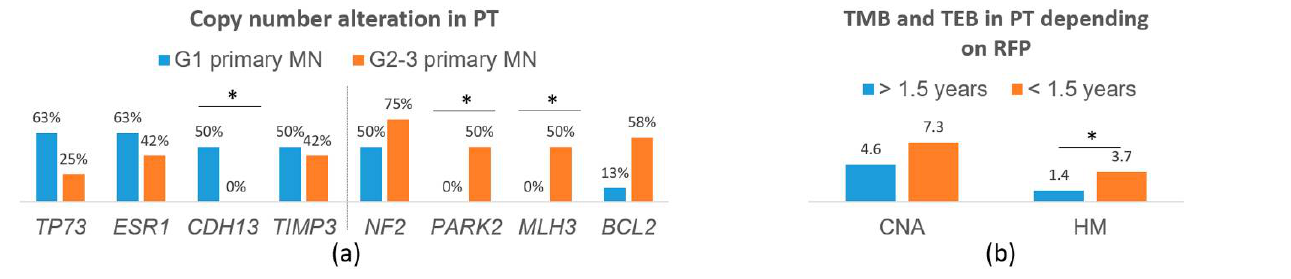
Figure 1. Genetic and epigenetic main characteristics. ( a ) Outstanding somatic copy number altera- tions on primary meningiomas depending on the tumor grade. ( b ) Copy number alterations and tumor epimutation burden (average number of epigenetic changes) according to recurrence-free survival period, divided into less than 1.5 years to the first recurrence or more than 1.5 years to the first recurrence. ( c ) Kaplan–Meier analysis of recurrence-free survival shows three independent prognostic factors: CDKN2B and PTEN epigenetic alterations (HM), and HIC1 copy number altera- tion (CNA). In each graph, the wild-type situation is in red and HM or CNA is in blue. ( d ) Cox Hazard ratio data to corroborate the strength of Kaplan–Meier analysis. ( e ) Evolution of the genetic and epigenetic burden from primary meningiomas to the first recurrence. ( f ) Pearson’s correlation analysis on primary meningiomas (PT) −1, and their first recurrences (RC1) −2. Positive correlations are in red meaning statistical co-alteration of a pair of genes, both in 1 and in 2. Negative correlations